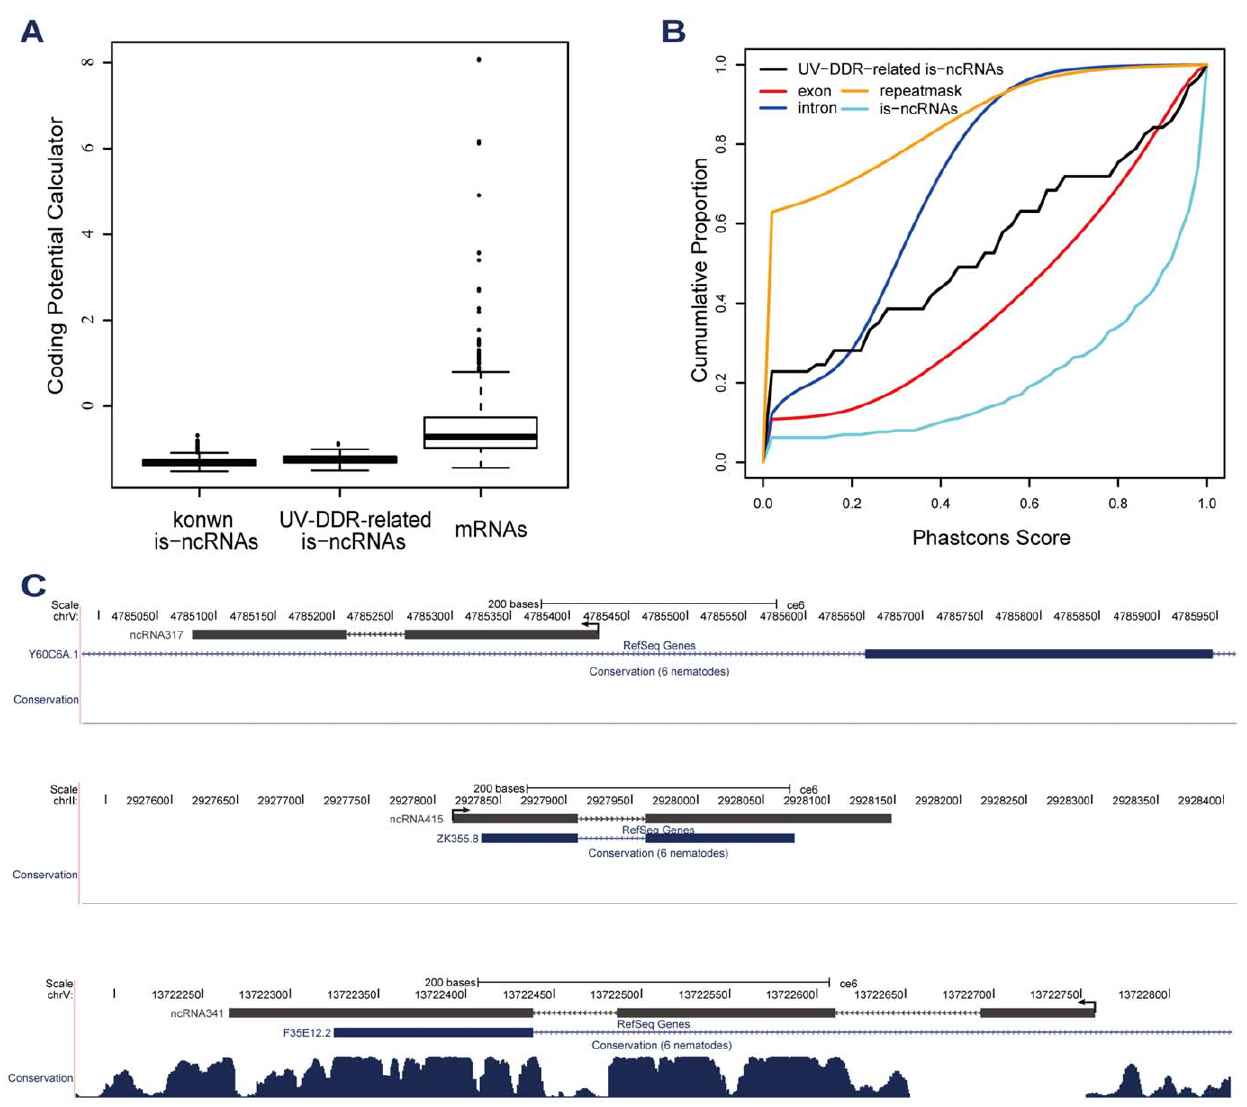
Figure 3. Characteristics of UV-DDR-related is-ncRNAs. A, Coding potential. Coding potentials of known is-ncRNAs, UV-DDR-related is-ncRNAs and 570 randomly selected mRNAs were analysed using CPC. B, Conservation. Conservation of the genomic transcript sequence for repeat sequences, exons, introns, known is-ncRNAs and 57 UV-DDR-related ncRNAs (UV-ncRNA). C, Conservation and location of the three is-ncRNAs. RefSeq genes are in blue and ncRNAs are in gray. Arrows indicate the direction of transcription. The extent of conservation varies with genomic location and is based on PhastCons scores in UCSC. ncRNA317 is located antisense to the intron of protein-coding gene Y60C6A.1. ncRNA415 is an intergenic transcript. Based on our sequencing and 3 9 RACE results, the 5 9 - and 3 9 -end of ncRNA415 was extended 22 nt and 74 nt, respectively, as shown. ncRNA341 comprises 3 exons, which are located at positions equivalent to the deeply conserved regions of RefSeq gene F35E12.2 .